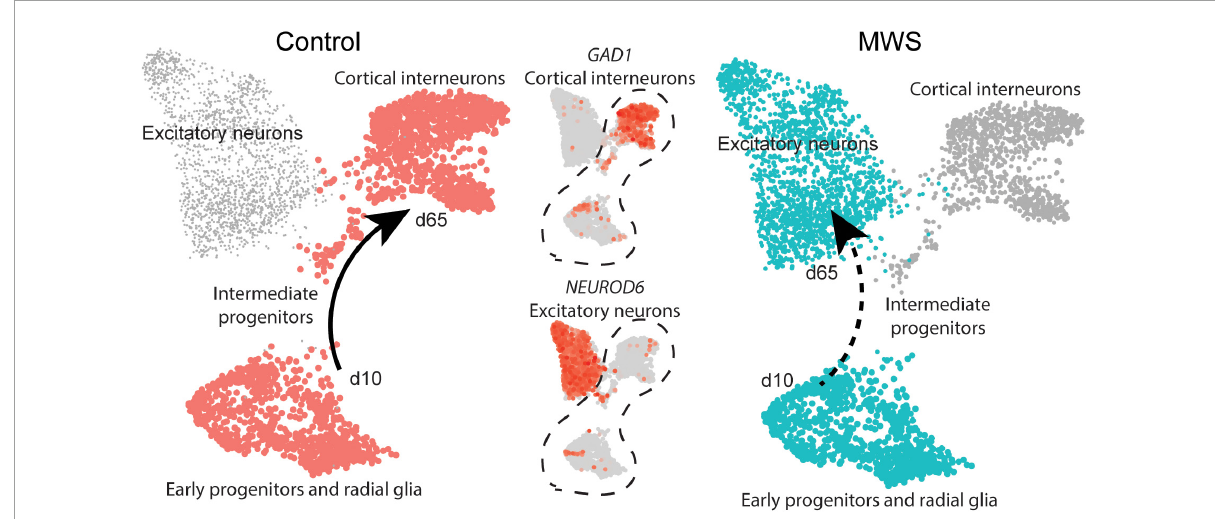
FIGURE4 MW-iPSC with ZEB2 haploinsufficiency exhibit an aberrant interneuronal differentiation trajectory. The expression levels of GAD1 and NEUROD6 in Ctl-iPSC GABA ( n = 2) and MW-iPSC GABA from RNAseq were inferred on pseudo-time trajectories of human cortex development. The expression of both genes in Ctl-iPSC GABA (left) are consistent with expression following the expected trajectory of cortical interneurons (Control, cell types highlighted in red). In MW-iPSC derived neural cells (MWS), the GAD1 and NEUROD6 expression suggests an early trajectory reminiscent of that for excitatory neuronal subtypes (dashed